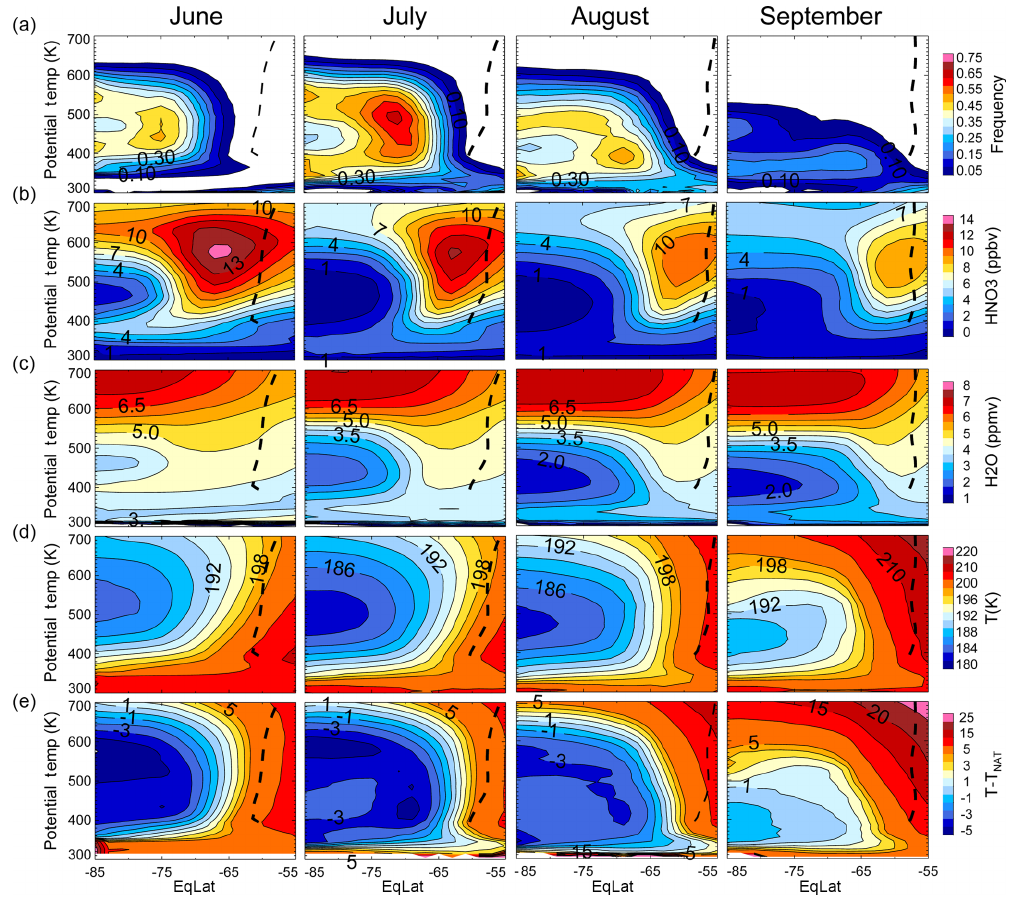
Figure 18. Equivalent-latitude–potential-temperature cross sections of 12-year average, monthly zonal mean (a) Antarctic PSC occurrence frequency, (b) cloud-free MLS HNO 3 , (c) cloud-free MLS H 2 O, (d) MERRA-2 temperature, and (e) T − T NAT . For reference, the mean location of the vortex edge (heavy dashed line) is indicated in the panels.